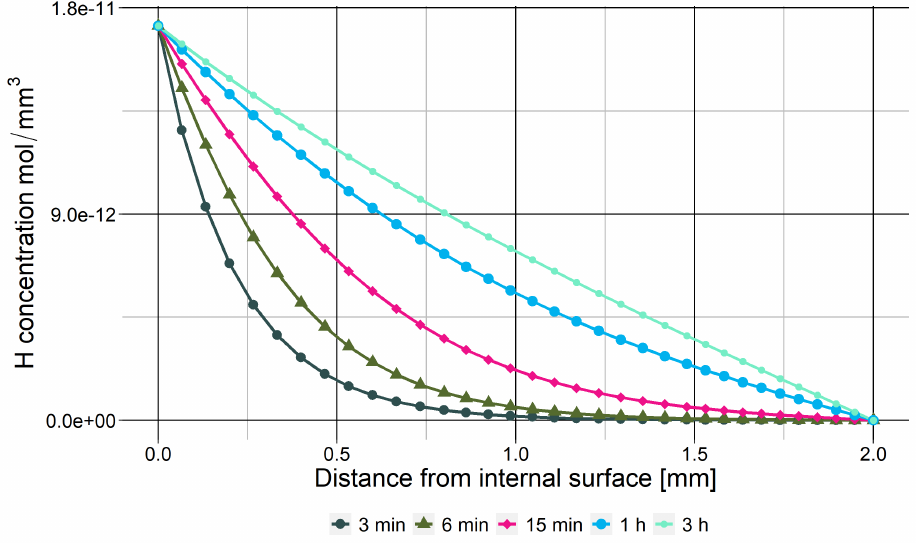
Figure 5. The evolution of the hydrogen concentration profile on the notch root plane with time. Equilibrium is reached after approximately 6